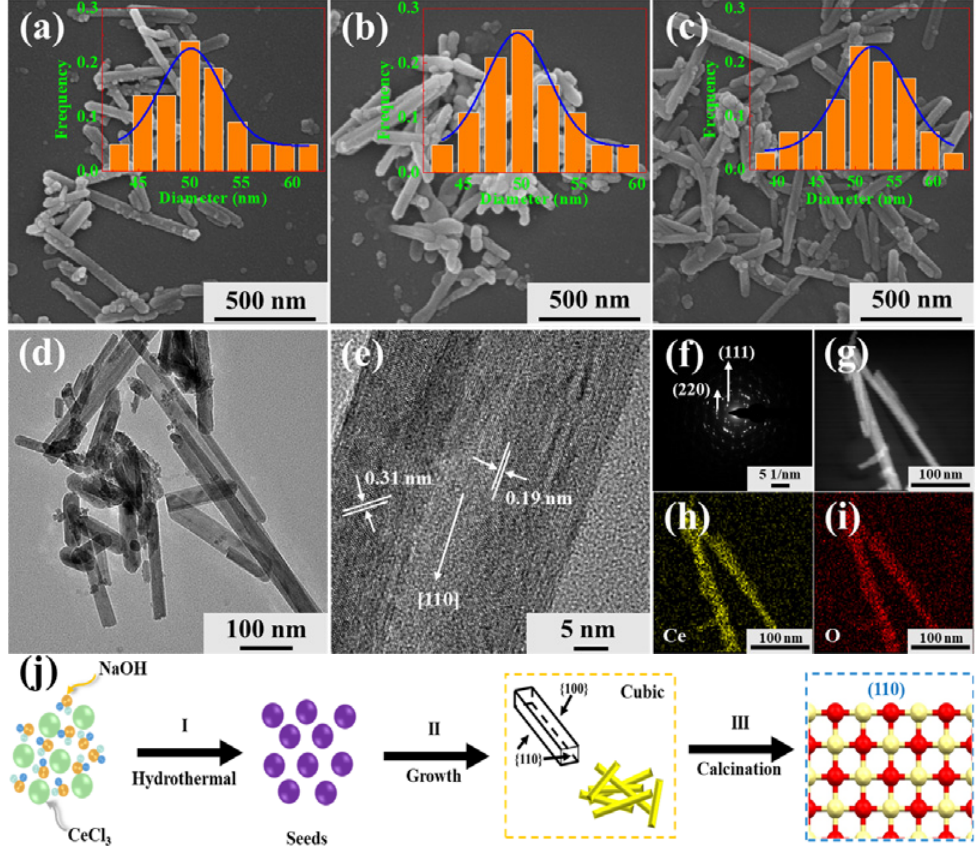
Fig. 2 (a–c) FE-SEM images of S1, S2, and S3; (d) TEM and (e) HRTEM images; (f) SAED image; (g) HAADF-STEM image; and (h, i) EDS mappings of S1. (j) Schematic diagram of formation mechanism of CeO 2